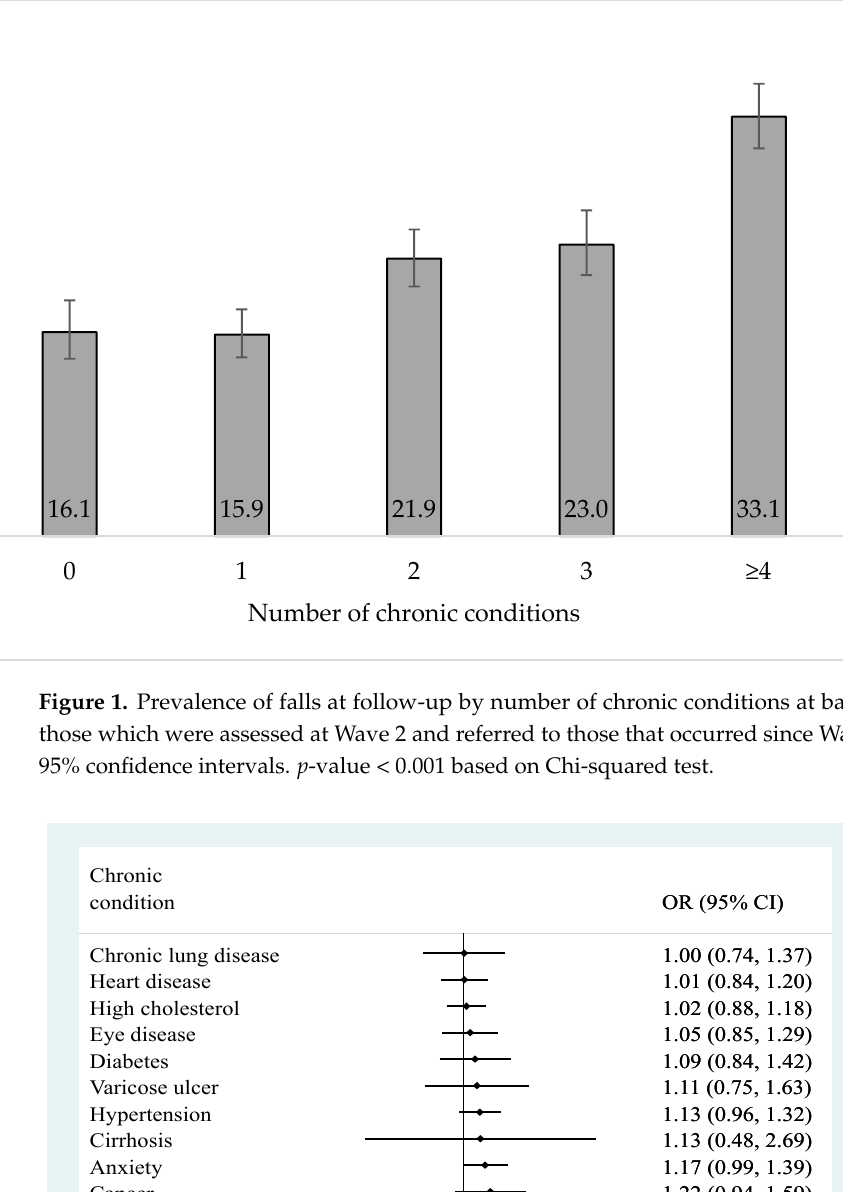
Table 2. Prospective association between the number of chronic conditions at baseline and falls at follow-up estimated by multivariable logistic regression.